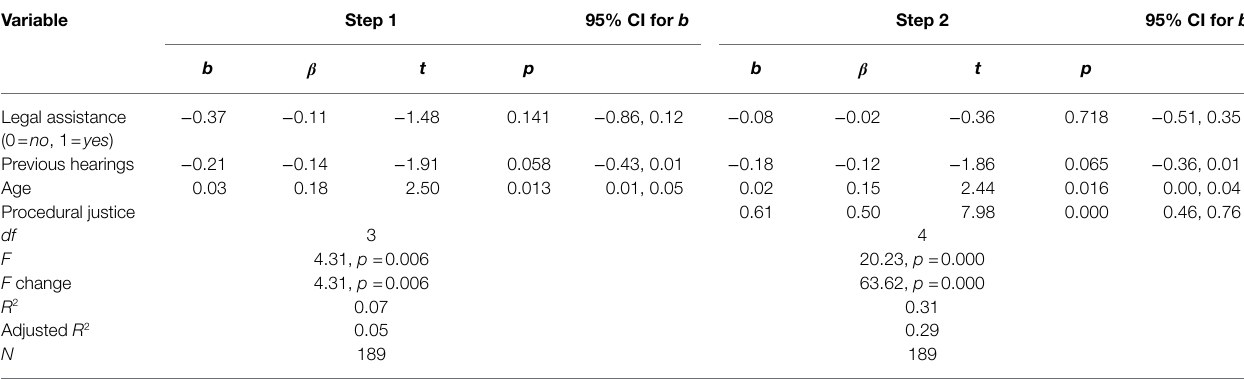
TABLE 3 | Trust in judges regressed on procedural justice and relevant background variables.